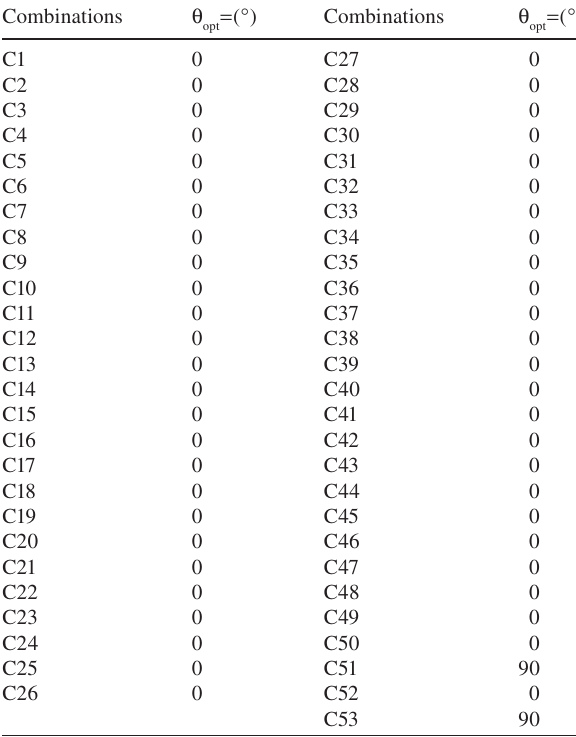
Table 7 Optimum fi ber orientations for laminated plates with intermediate line supports for ( SSSS ) boundary